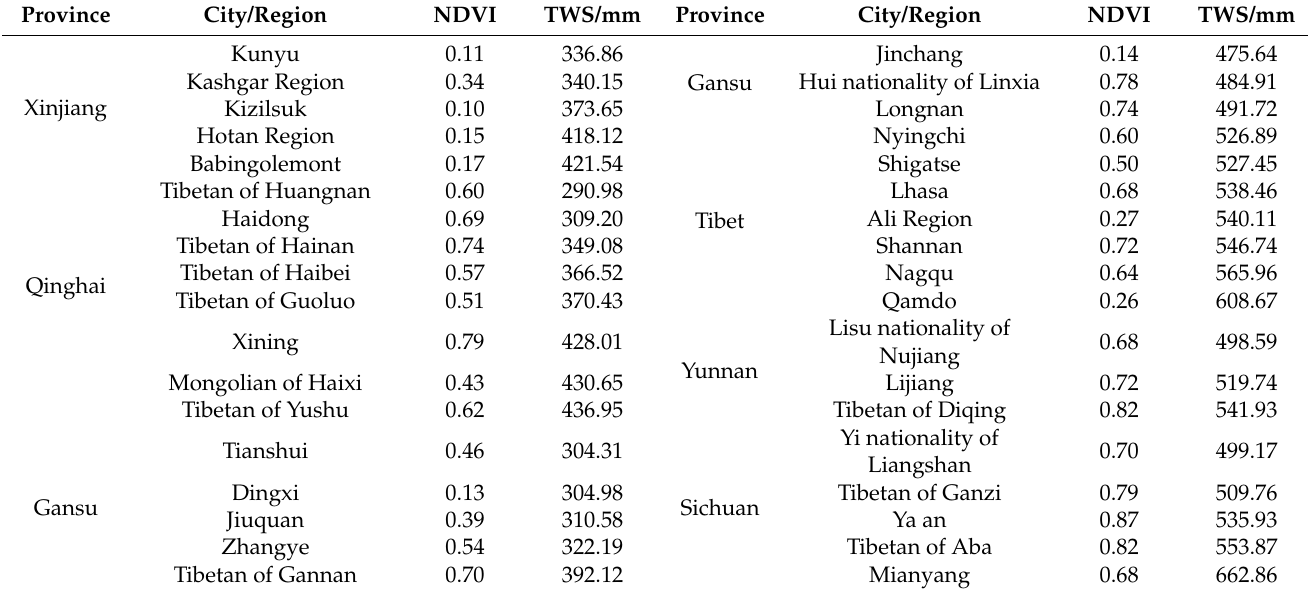
Table 4. The statistics of the average TWS and NDVI over the Tibetan